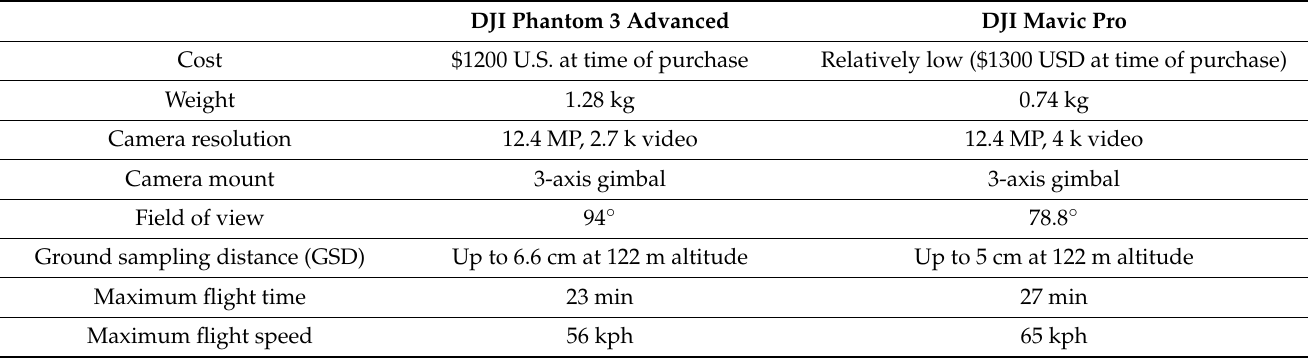
Table 1. Specifications of the two UAV platforms used for the study: the DJI Phantom 3 Advanced and the DJI Mavic